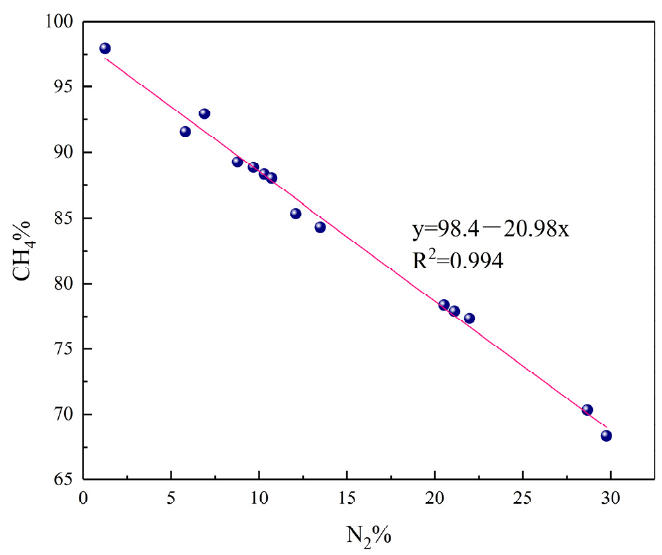
Figure 14. Correlation between N 2 and CH 4 in gas compositions.